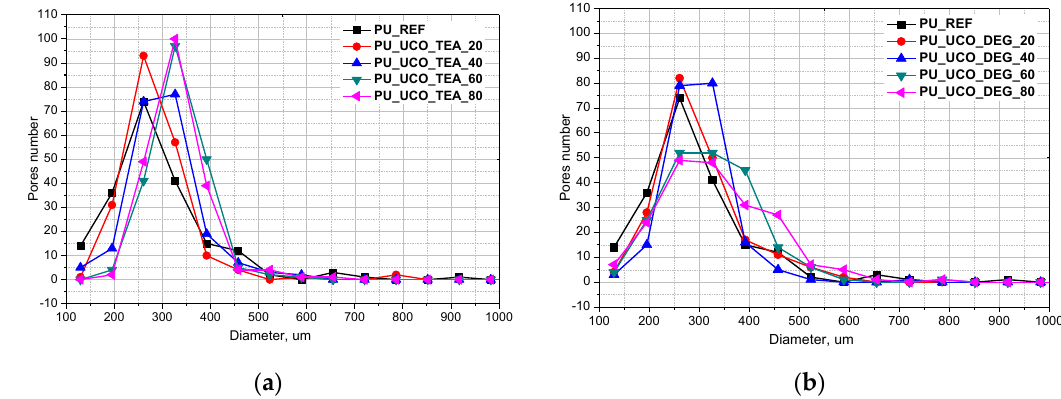
Figure 6. Pore size distribution for PU_REF and foams modified with polyols UCO_TEA ( a ) and UCO_DEG ( b ). Table 4. Apparent density, heat conduction coefficient and closed cell content of foam materials containing different amounts of UCO_TEA and UCO_DEG.